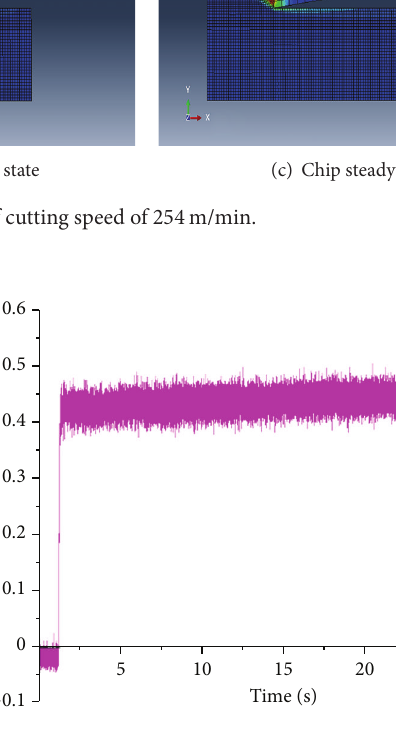
Figure 7: The main cutting force curve of dynamometer measure-